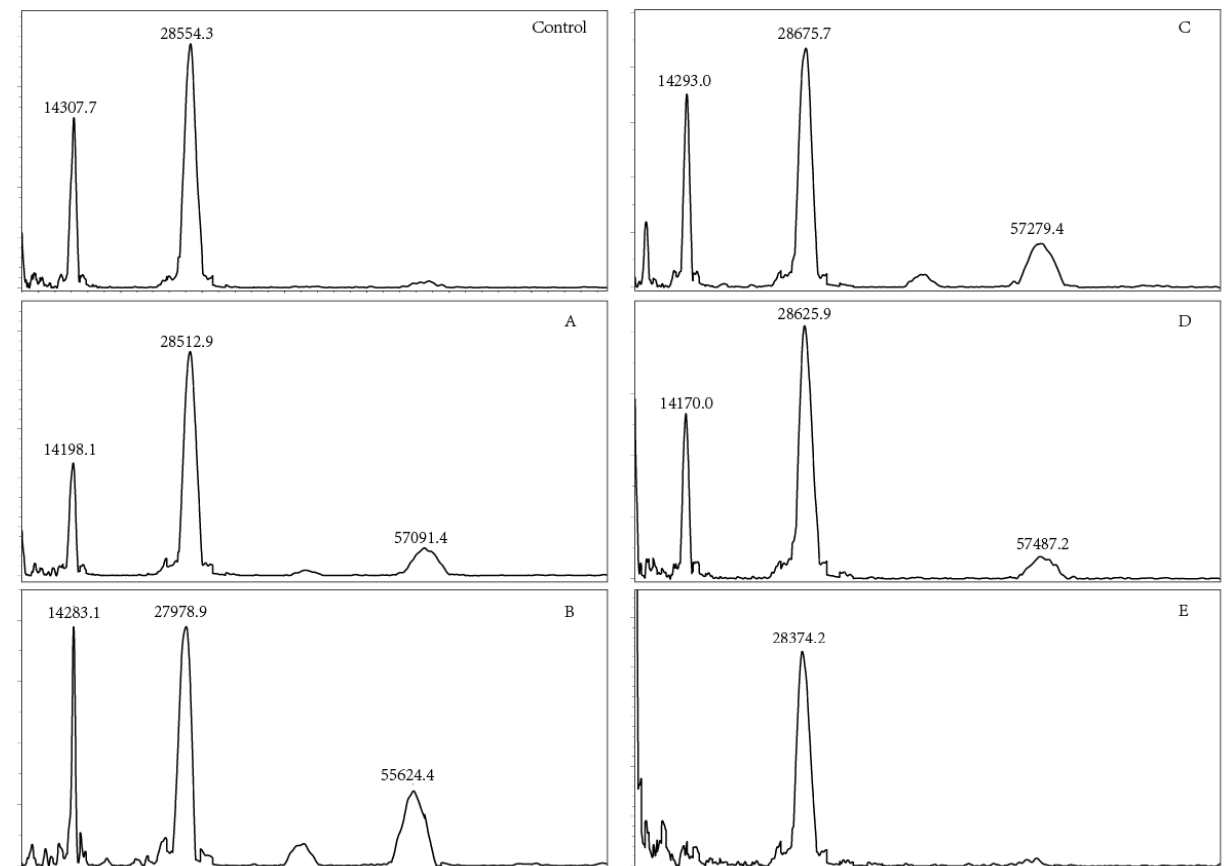
Figure 5. MALDI TOF MS of OVM treated by SS at different temperatures ( Control , native OVM; ( A – E ), OVM treated with SS at 120, 140, 160, 180 and 200 °C, respectively, for 10 min).